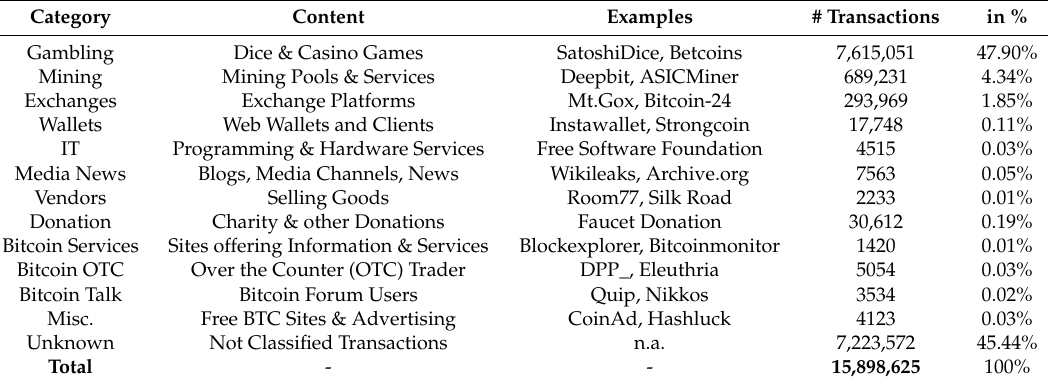
Table 3. Business